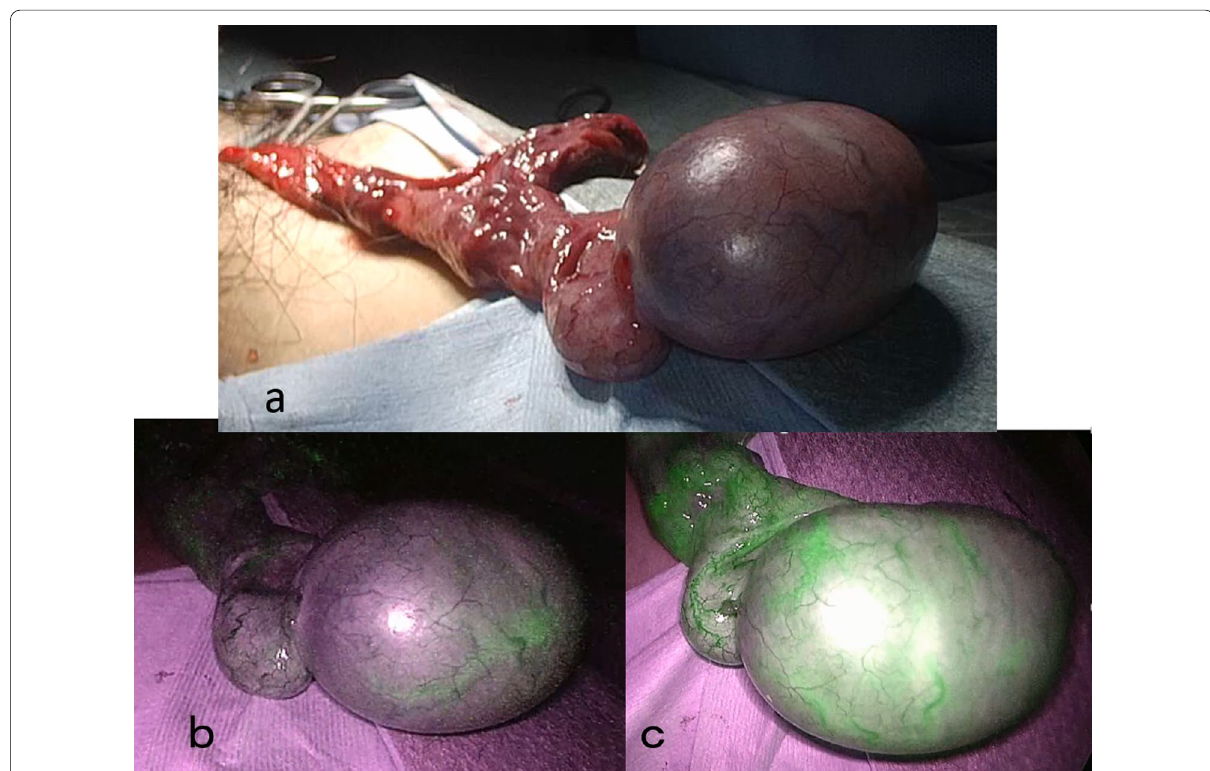
Fig. 2 Evaluation of testicular blood flow by intraoperative ICG. a After manual detorsion was performed, the testis was cyanotic and showed macroscopically poor blood flow. b Five seconds after ICG injection, testicular vessels began to show the presence of the dye. c An excellent ICG dye signal appeared after 45 s and it was deemed that the testis was still viable and could be preserved